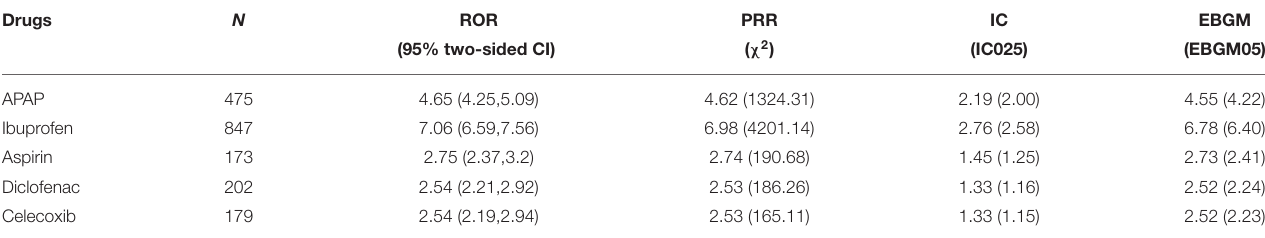
TABLE 2 | Signal detection for NSAIDs-associated Stevens-Johnson